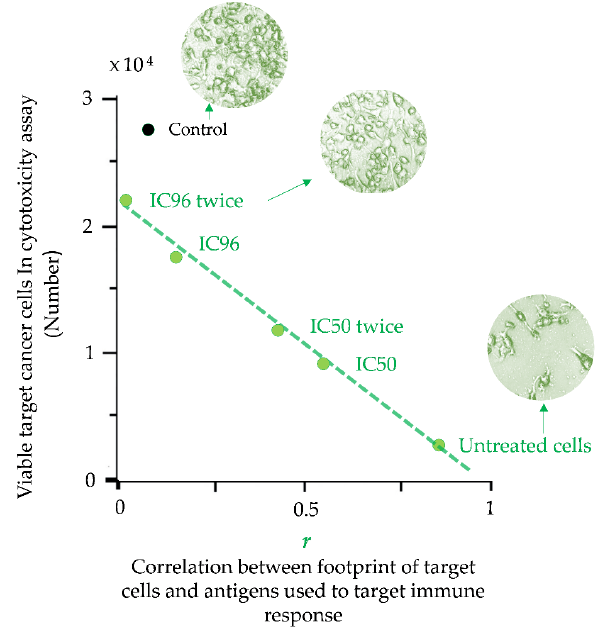
Figure 4. Escape of target cancer cells from the immune response in the cytotoxicity assay (CTA) as a result of their surface profile changes induced by the drug treatment. Points are presented for untreated MCF-7 target cells or cells treated with a single IC96 or IC50 dose of etoposide or two separate IC96 or IC50 doses (‘twice’) of etoposide (adapted from [80]). A linear approximation is shown. The average number of viable cells for the 3 experiments is presented. Correlation coefficients ( r ) were calculated for the correlation between the antigenic composition used to induce an immune response in CTA (known as cellular antigenic essence [89]) and the proteomic footprints of target cancer cells. ‘Control’ corresponds to the immune response induced by the control antigen composition (non-relevant to target MCF-7 cells). The data in the graph show that the escape of target cells from the immune response is directly related to the degree of change in their proteomic